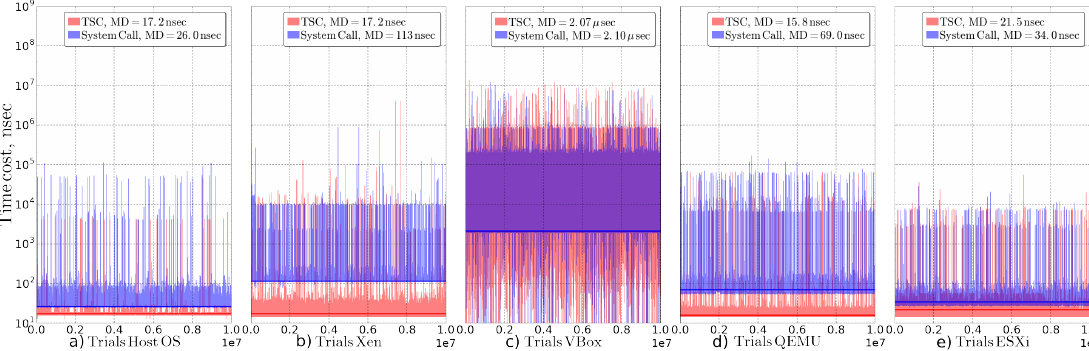
Figure 8. Measurements of timer cost for the IO/network testbed on: ( a ) Host OS; ( b ) Xen; ( c ) Virtual Box; ( d ) QEMU; and ( e ) VMware ESXi.